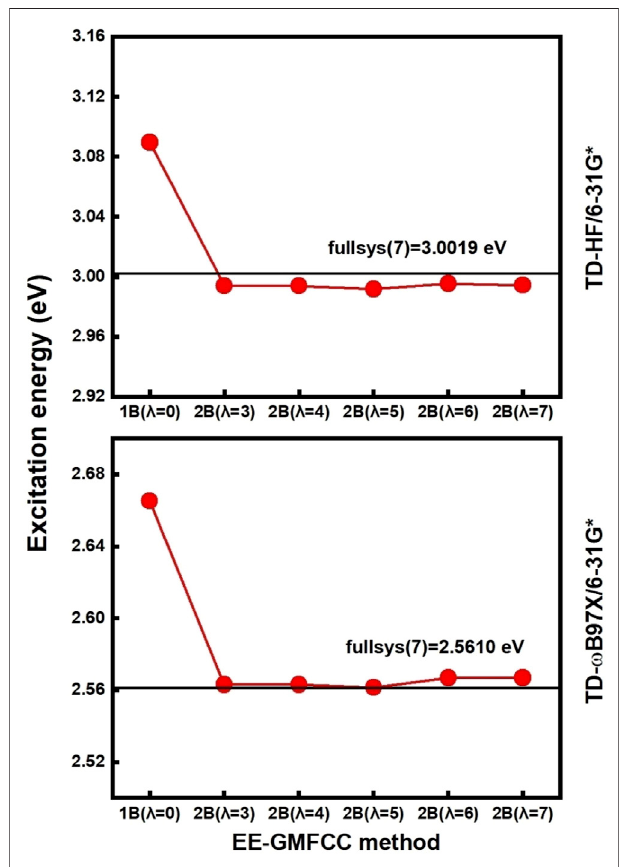
FIGURE3| Calculatedexcitationenergies(redline)usingEE-GMFCCas a function of the distance threshold of λ 2 B at the TD-HF/6-31G* and TD- ω B97X/6-31G* levels, respectively. The calculated excitation energies from the model system of fullsys (7) constructed using λ FS (cid:2) 7 Å are regarded as the reference (black line).